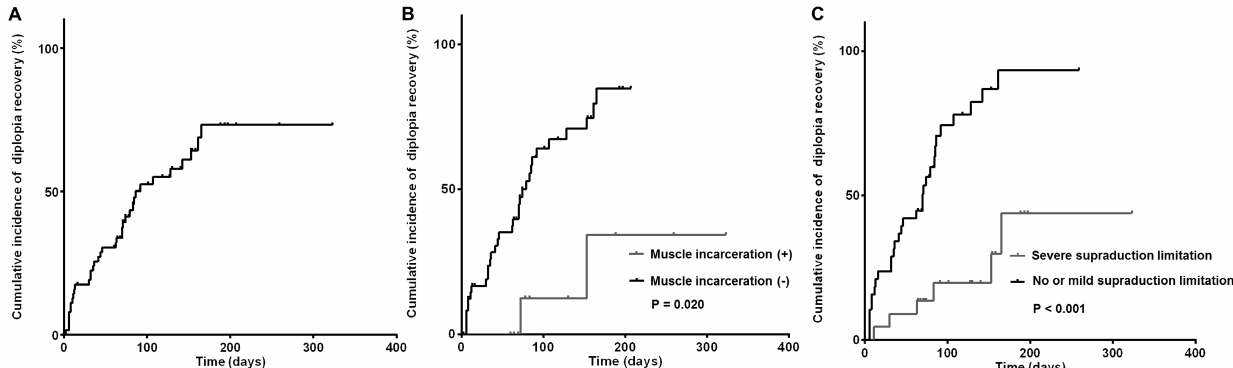
Fig 1. Kaplan-Meier curves of recovery of patient-reported diplopia. (A) Cumulativeincidenceof resolvedpatient-reported diplopiain pediatricpatients with orbital wall fracture. The cumulative incidenceof resolved diplopiaat 3 months was 37.9% and diplopiawas finally recovered in 34 patients (50.0%). (B) Univariateanalyseson risk factors associatedwith patient-reported diplopia.Patients with muscle incarceration showeddelayedrecovery of diplopiacompared to those without muscle incarceration. (C) Patients with severe supraduction limitation(grade -3 or -4) experienced delayedrecovery of diplopiacomparedto those with no limitation or mild supraduction limitation(grade 0, -1 or -2).